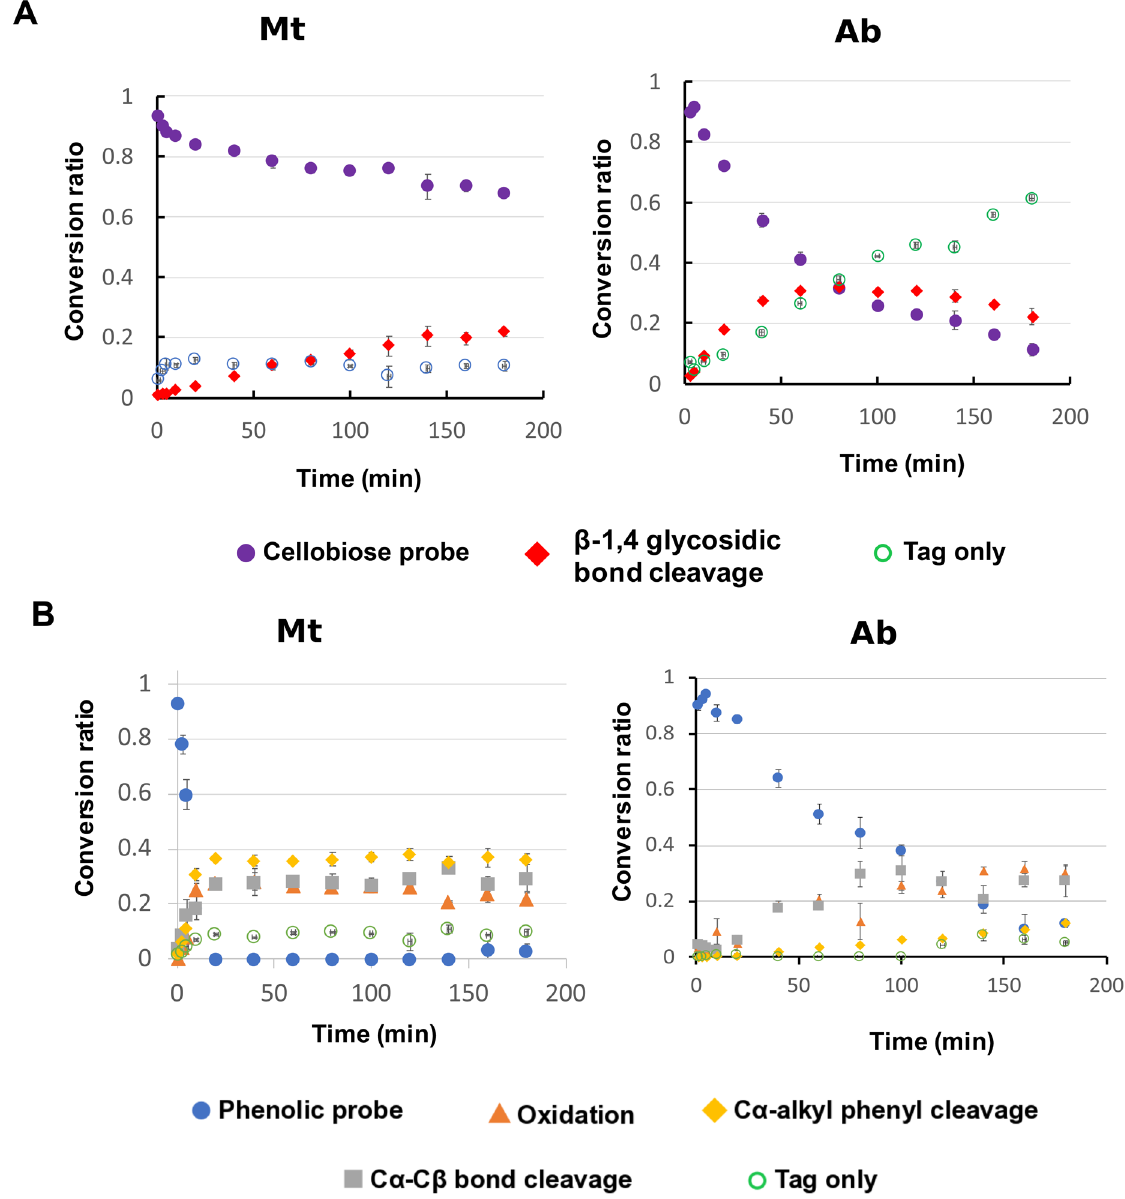
Figure 3. Multiplex assays against mixed GH and LME probes (n = 3). ( A ) Conversion of GH probe in the presence of LME probe. ( B ) Conversion of LME probe in the presence of GH probe. Enzyme loading concentrations were 0.74 μg and 0.15 μg per 1.66 mM total substrate (0.83 mM GH probe and 0.83 mM LME probe) for Mt and Ab,